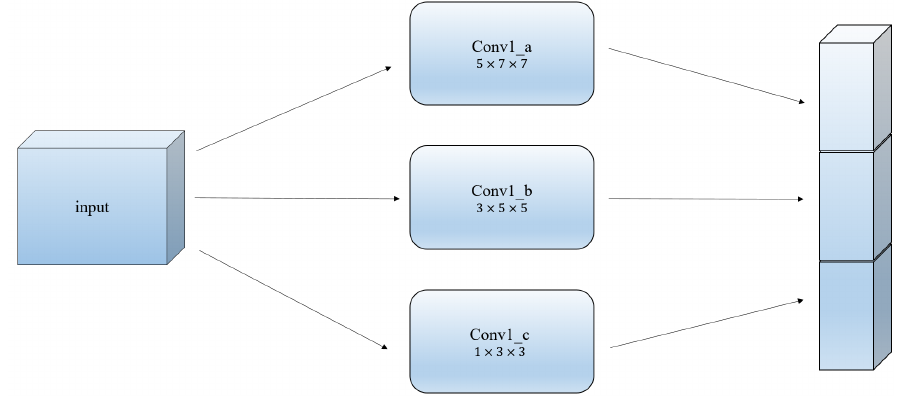
Figure 4. Multi-scale CNN.